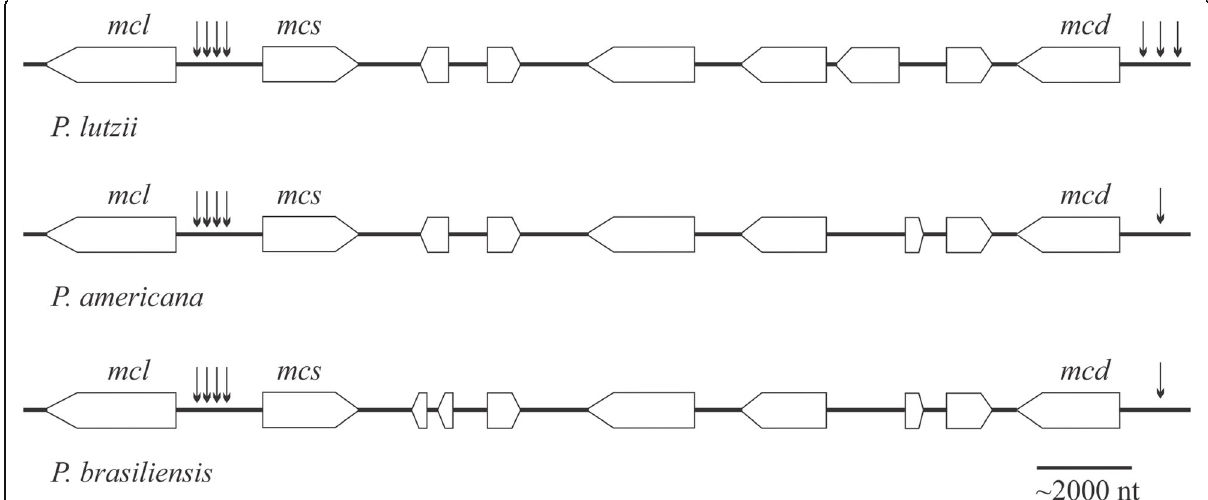
Fig. 2 Genomic organization of methylcitrate cycle genes. Synteny of MCC genes in Paracoccidioides spp. genomes. The putative CreA binding motifs 5 ′ -(G/C)YGGRG-3 ′ are denoted by